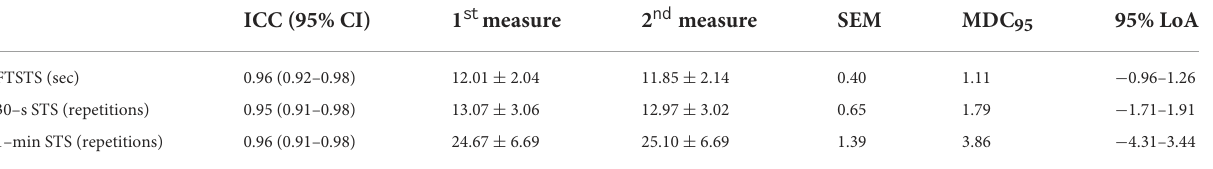
TABLE 3 Relative and absolute reliability results of the three STS tests ( n = 30).